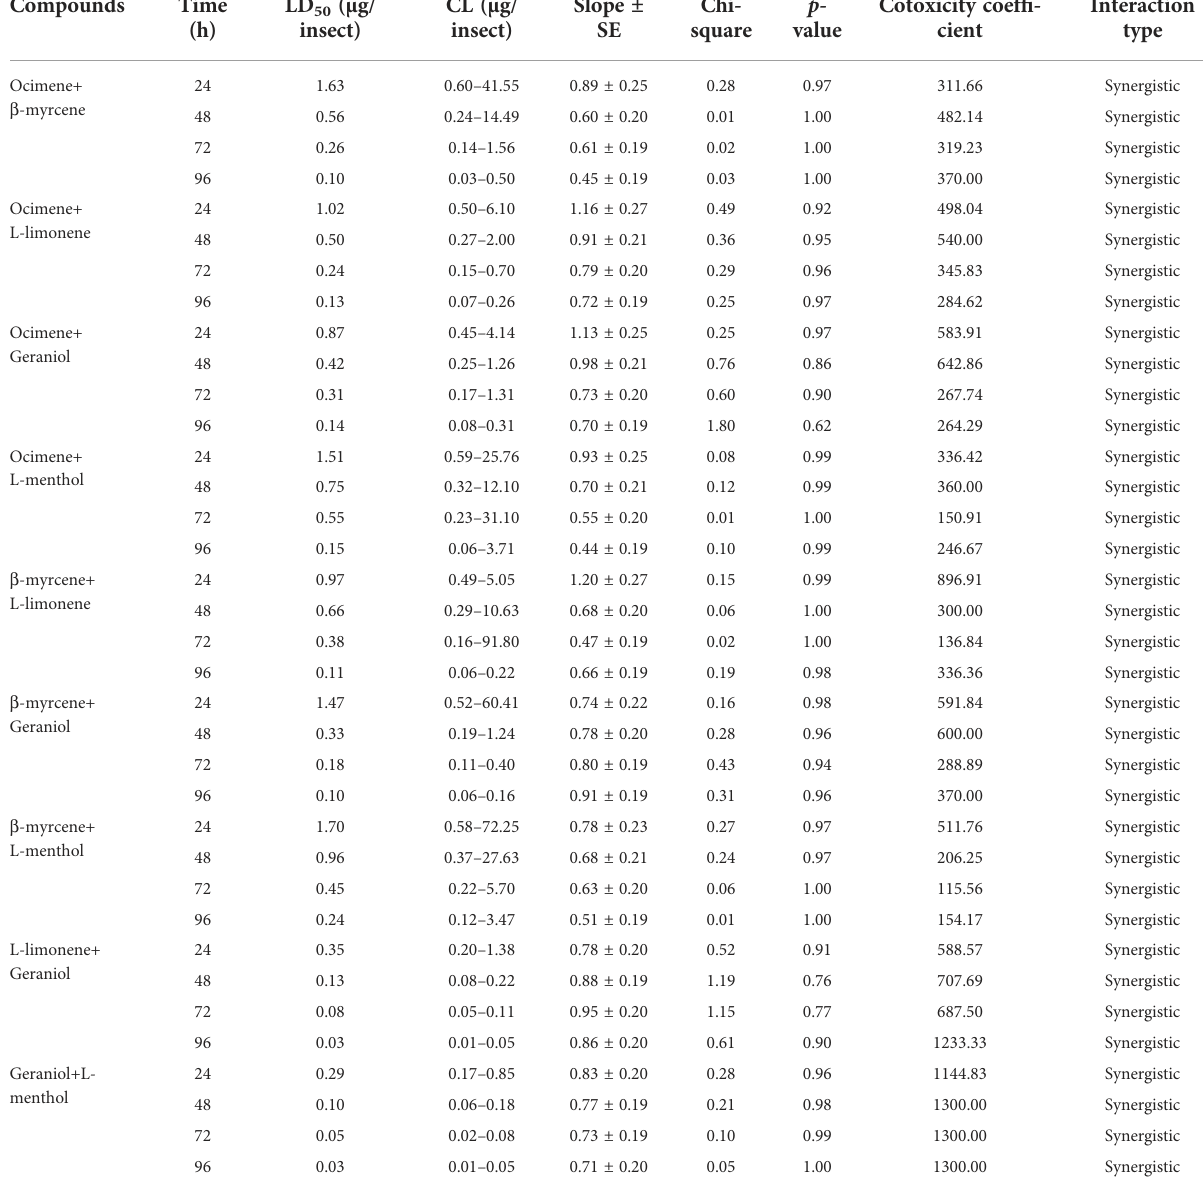
TABLE 2 Toxicity of various combined compounds against the second instar crawlers of P. lilacinus .